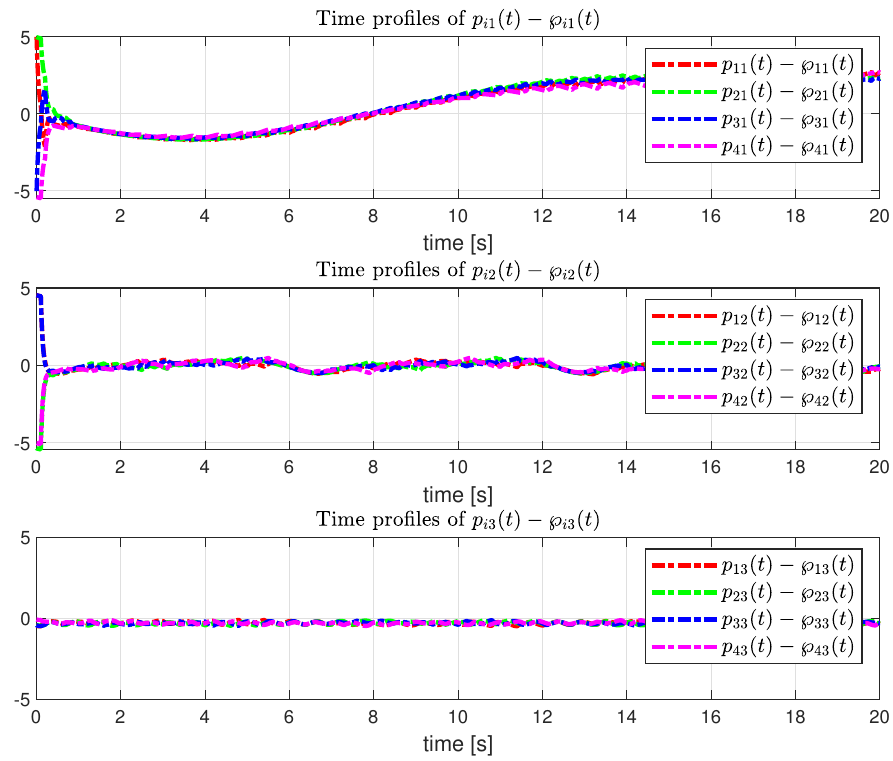
Figure 16. Performance of the pseudo position estimator subject to relative position measurement noise with n P =